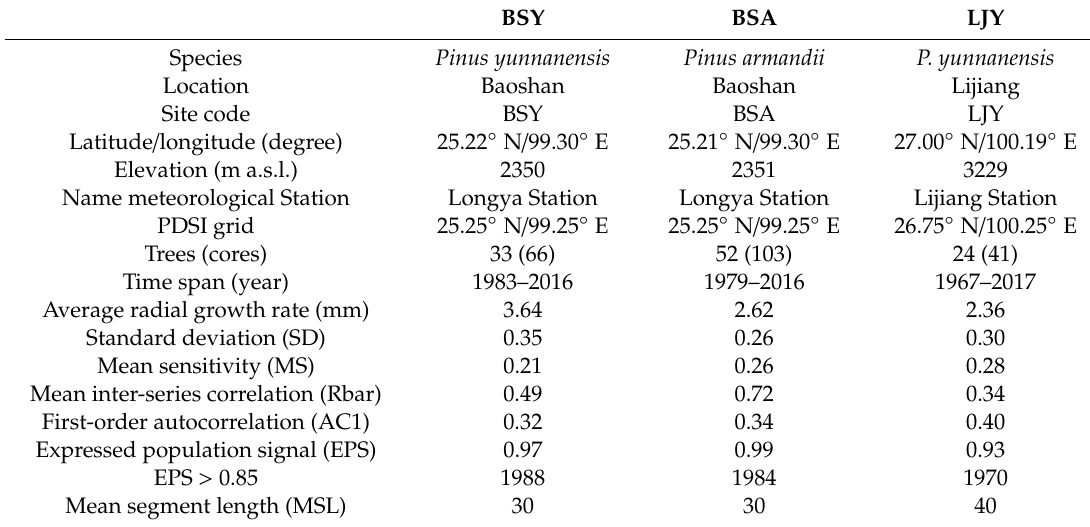
Table 1. Sampling locations and statistics of tree-ring chronologies of pine trees in Baoshan and Lijiang, Yunnan, southwest